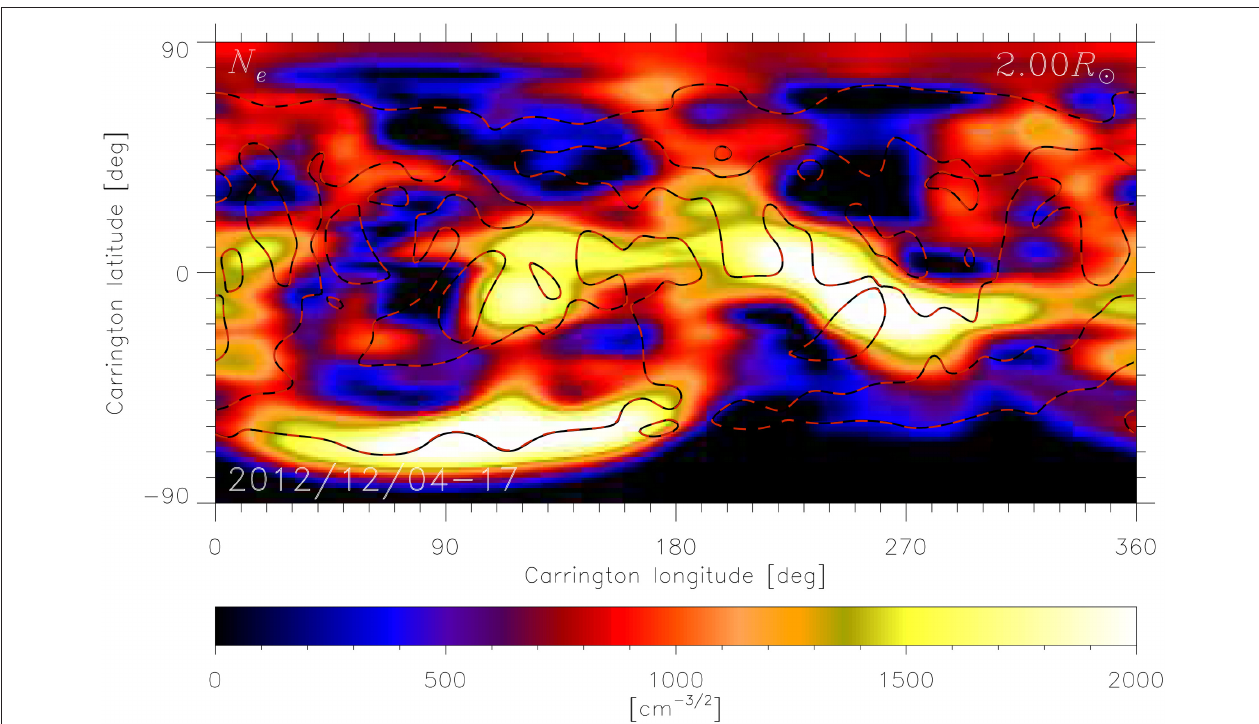
FIGURE 1 | Spherical cross-section of the reconstructed electron density in square root scale at heliocentric distance of 2 R ⊙ . The reconstruction is obtained by tomography based on COR-1 data obtained during December 4–17, 2012 (CR 2131). Solid black and dashed red lines indicate the magnetic neutral line in PFSS model with source surface located at 1.5 and 2 R ⊙ ,